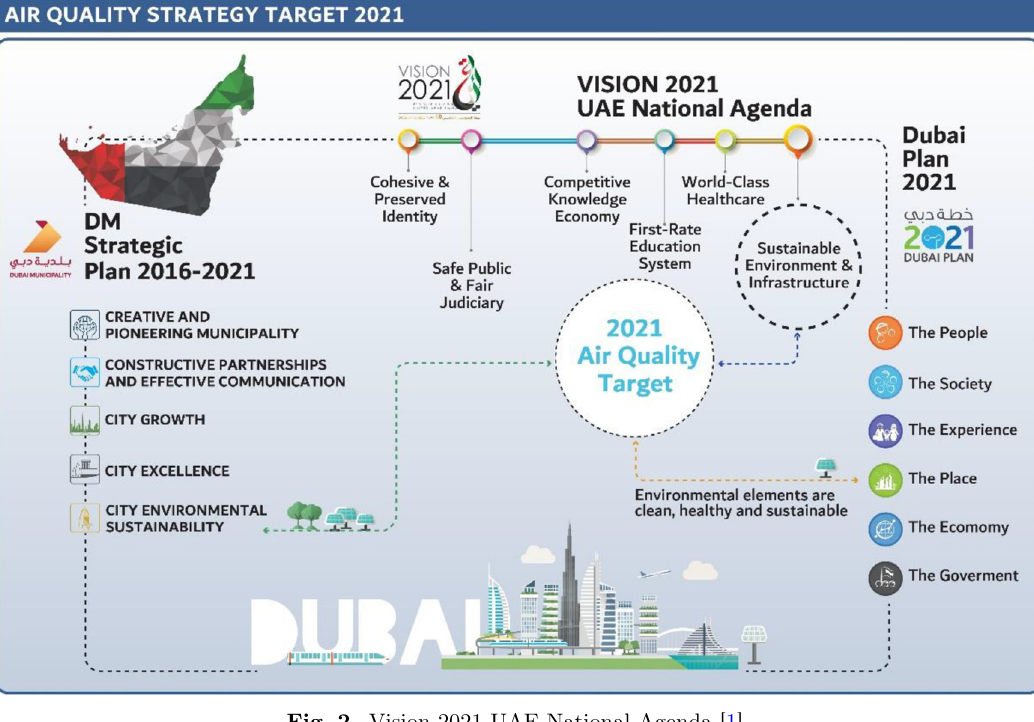
Fig. 2. Vision 2021 UAE National Agenda [1].